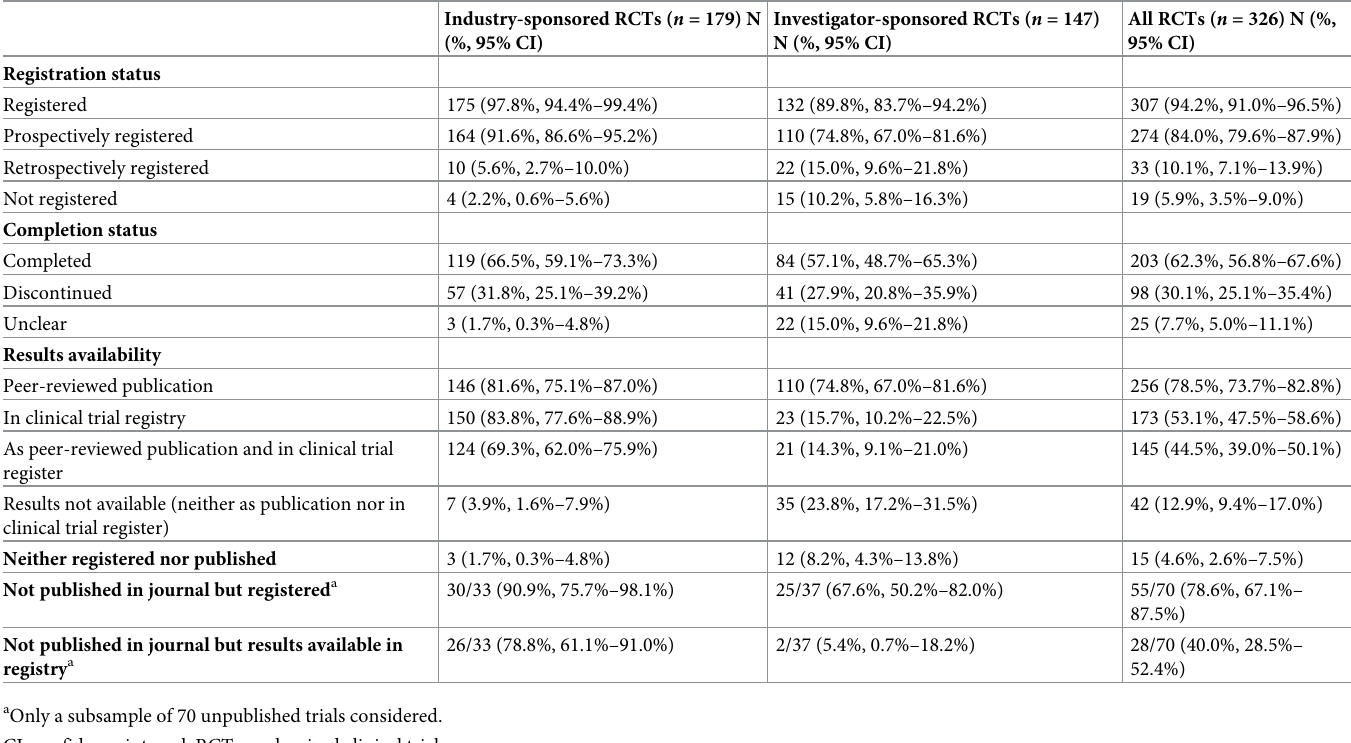
Table 2. Registration, completion, and publication status of RCTs approved by research ethics committees in 2012.